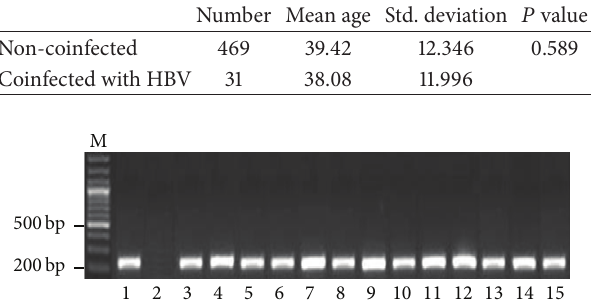
Figure 1: A representative 1.5% agarose gel of PCR products for the detection of HCV. Lane M: DNA marker, lane 1: positive control (227 bp), lane 2: negative control, and lanes 3 to 15: patients positive for HCV